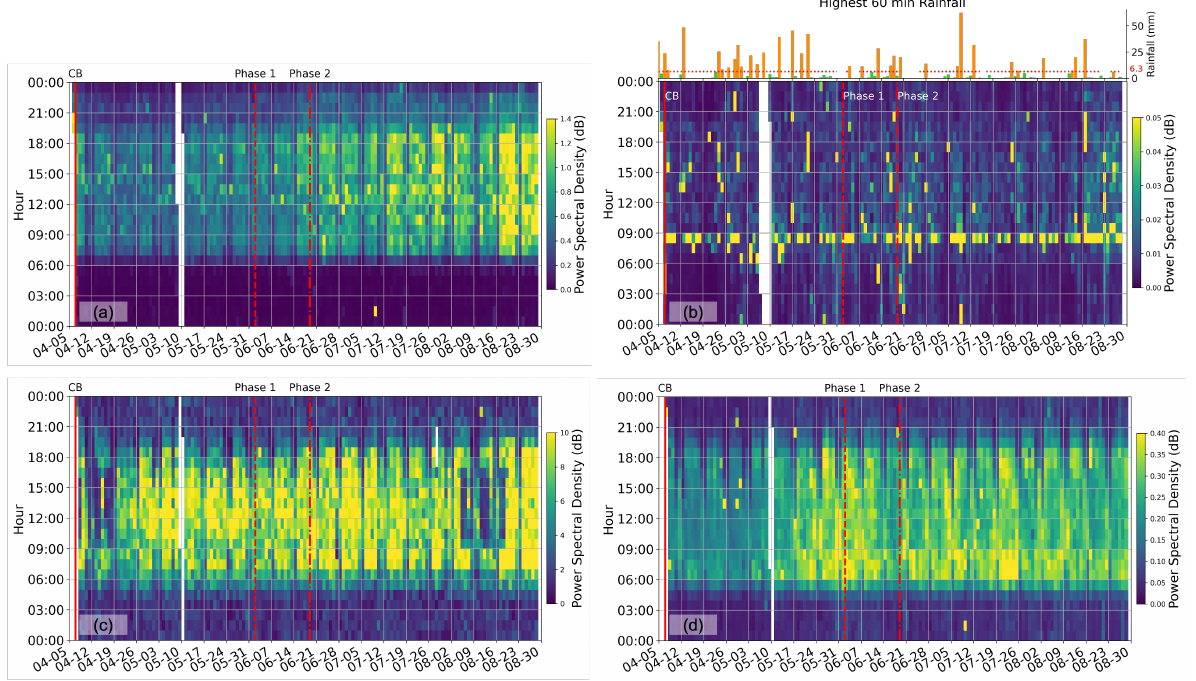
Figure 3. Cumulative power spectral density (PSD) between 30 and 150 Hz at ( a ) NUS hilltop, ( b ) NUS exit, ( c ) West Coast Highway, and ( d ) West Coast Park, respectively. The legends are the same as Figure 2. Rainfall data at the Kent Ridge weather station (denoted by the orange star in Figure 1) are plotted on top of ( b ), where days with intensive tropical downpours (highest 60 min rainfall greater than the mean value 6.3 mm) are plotted in orange, and the other days are plotted in